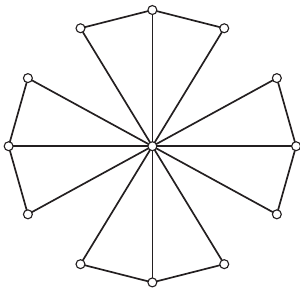
Figure 11. The analogous Dutch windmill graph AD 4